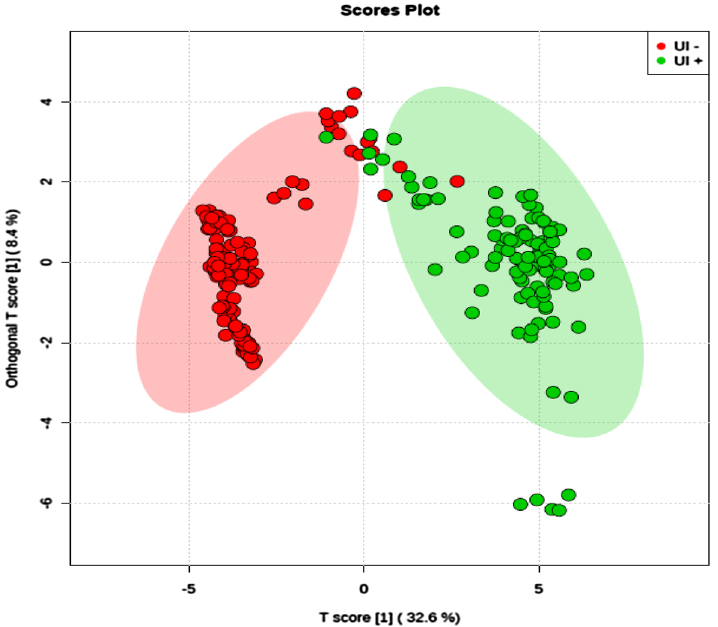
Figure 3. Unexplained Infertility Score Plot. Orthogonal partial least squares discriminant analysis (OPLS-DA) score plot model indicating separation between non-pregnant women (red) and pregnant women (green), both groups without a clinical diagnosis, clustering with data on positive ion mode. Figure generated using MetaboAnalyst (www. metab oanal yst. com). The mass spectrometry analysis was performed in quintuplicate for each sample, therefore each patient is represented by 5 (five) dots.